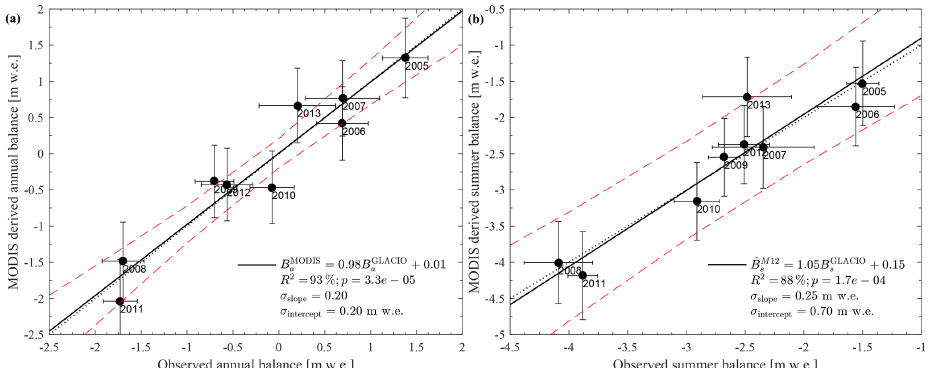
Figure 11. Relationship between MODIS-derived balance for (a) annual balance with Model M1 and (b) summer balance with Model M12. The dotted line is the 1 : 1 ratio. The dashed line is the standard error prediction